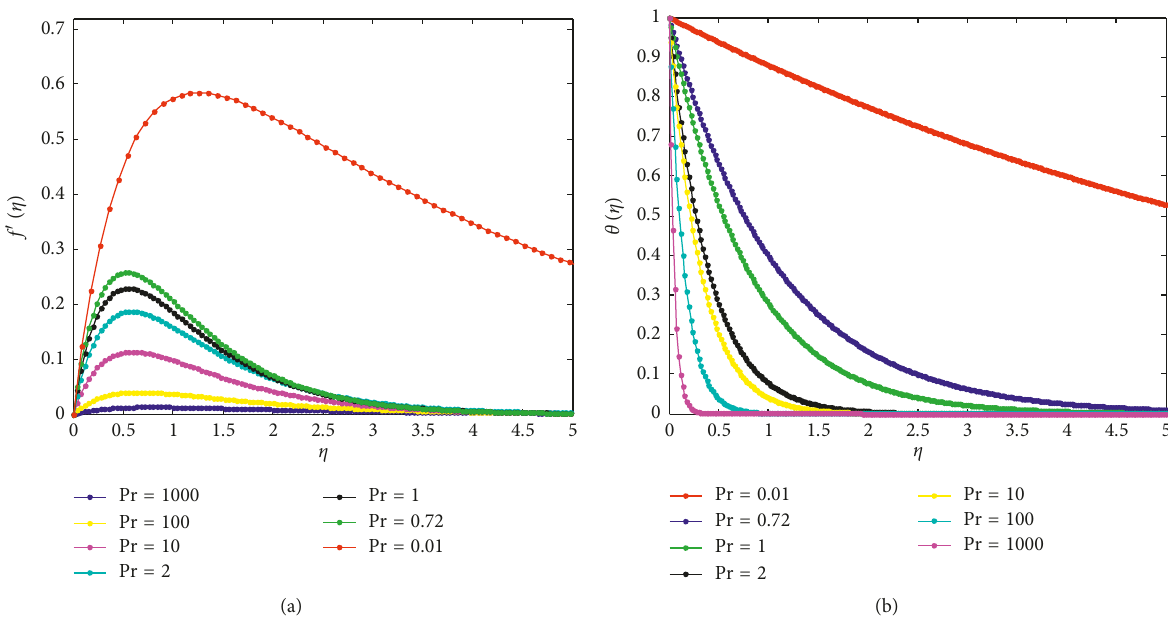
Figure 14: (a) Effects of Prandtl number on the velocity profile for platelet-shaped nanoparticle. (b) Effects of Prandtl number on the temperature profile for platelet-shaped nanoparticle.